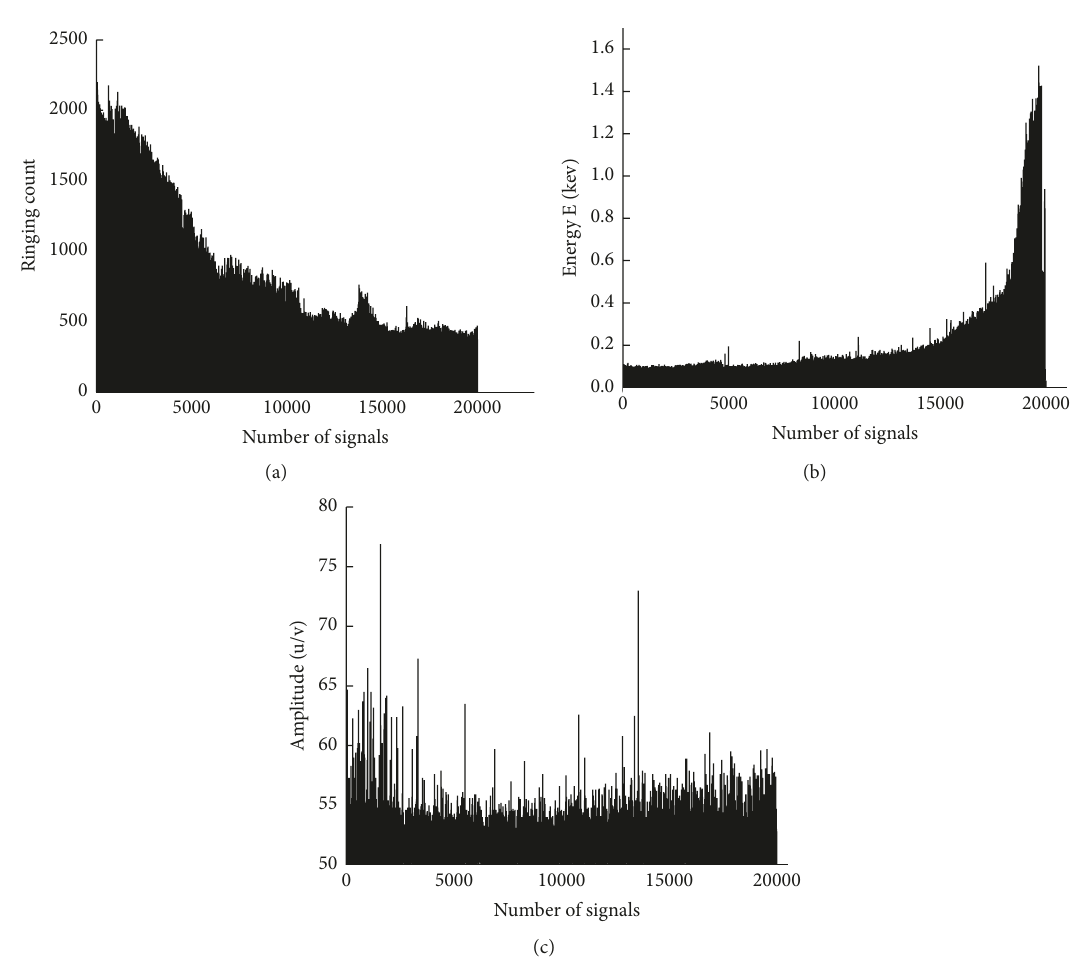
Figure 11: The original signal of acoustic emission ringing count (a), energy (b), and amplitude (c) of fatigue